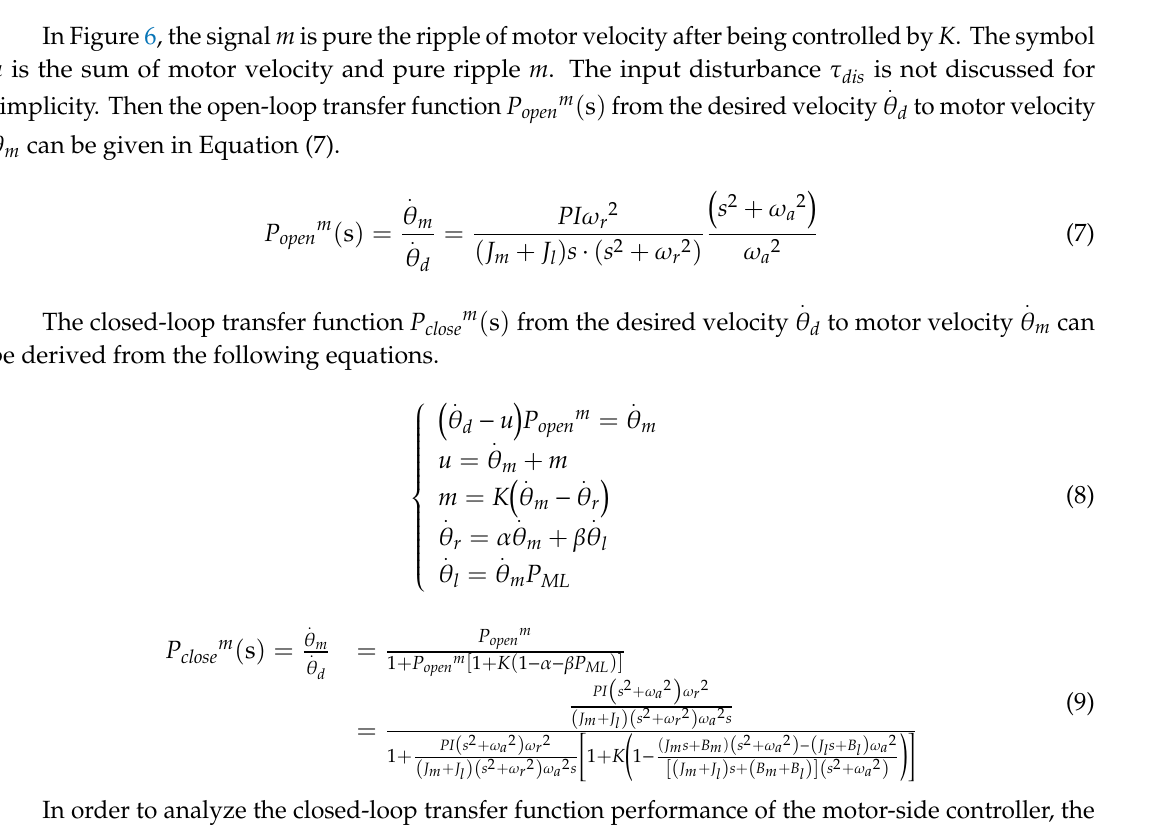
Figure 6. Block diagram of the motor-side controller.